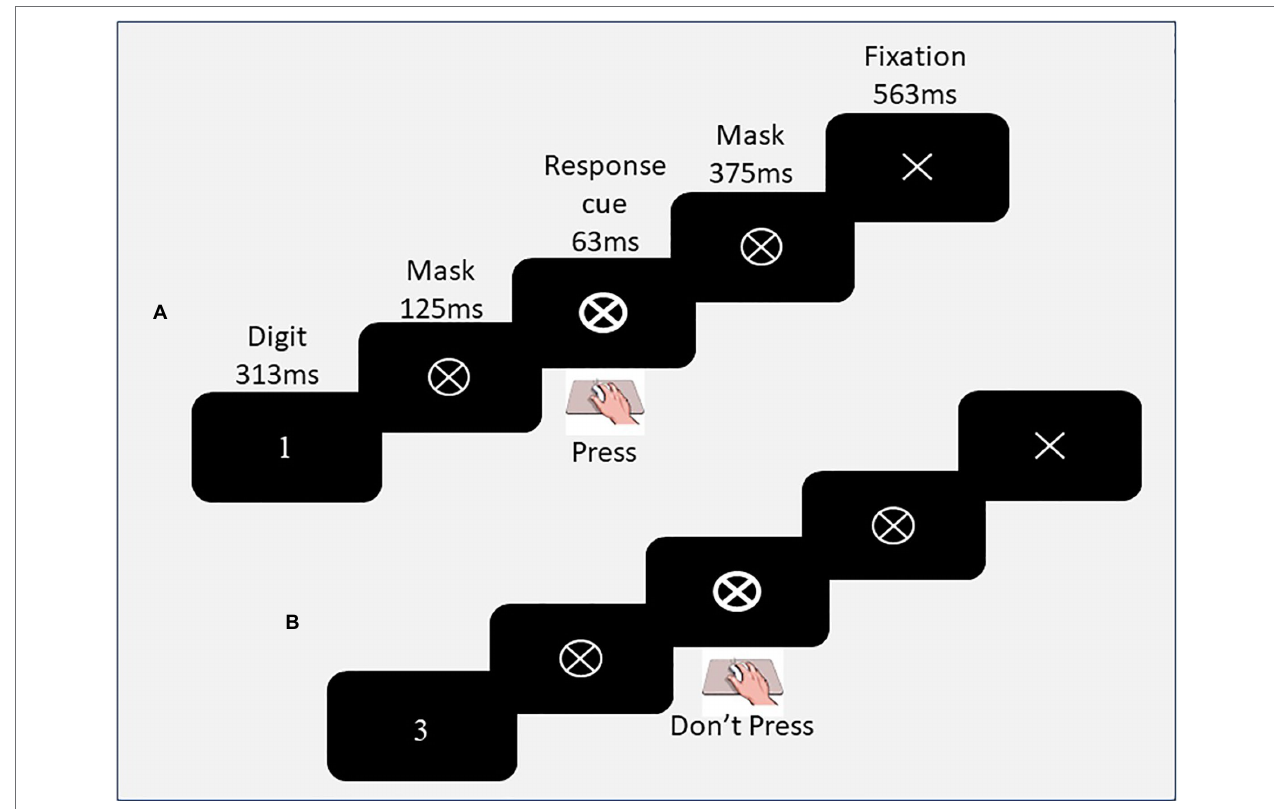
FIGURE 1 | The sustained attention to response task sequence of events and timings. Figure depicts (A) a go trial, requiring a response to the presentation of the go-digit 1, and (B) a no-go trial, requiring the withholding of a response to the no-go digit 3. In this Fixed version of the task, the digits 1–9 are presented within a fixed sequence, 25 times. Participants were asked to respond on the response